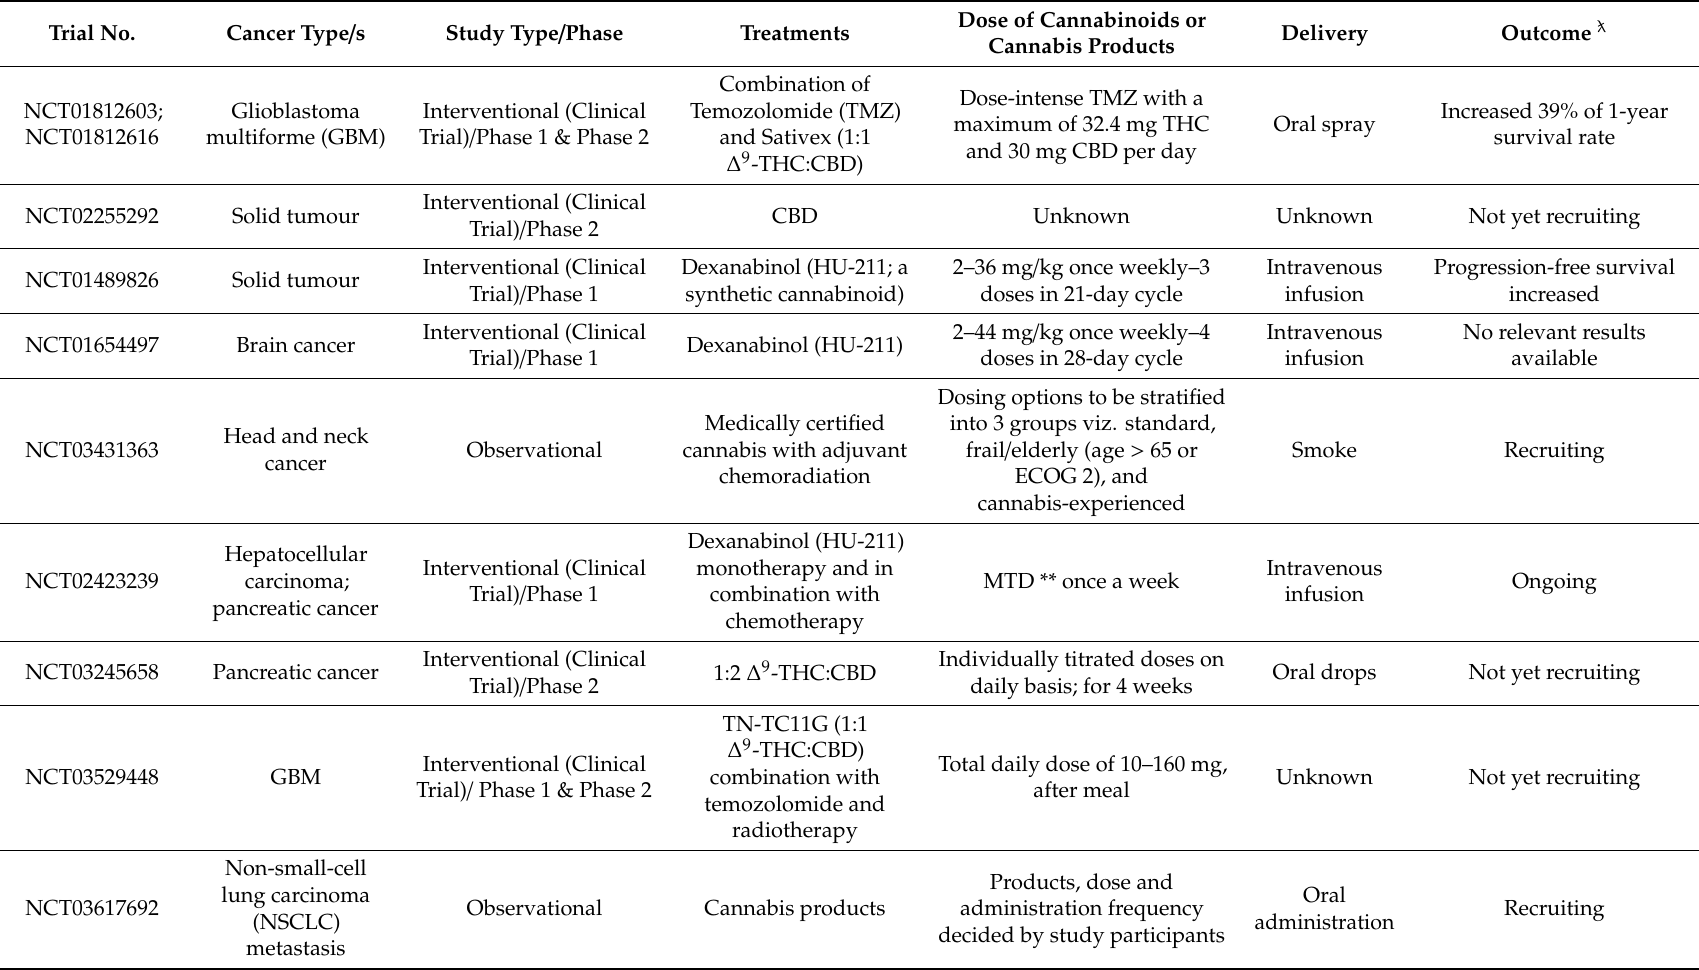
Table 2. Clinical trials using cannabinoids for the treatment of cancer